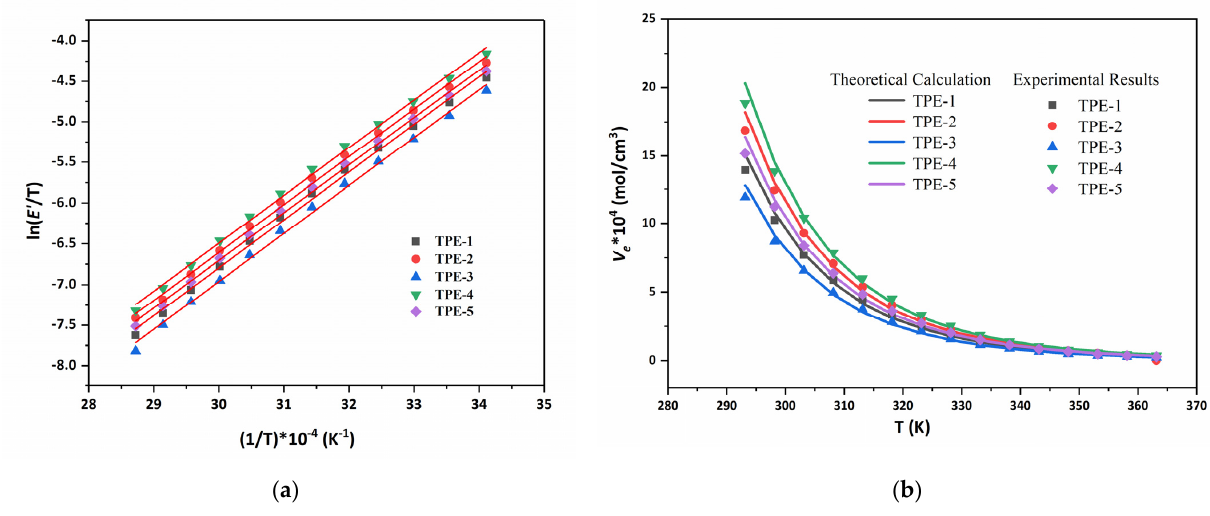
Figure 6. ( a ) Relationships between Δ V e and 1/T of TPEs. Red line is the regression results; ( b ) Effective crosslinking density of TPEs, theoretical calculation and experimental results. Table 2. The calculating parameters of TPEs (the results are obtained according to Equation (11)).